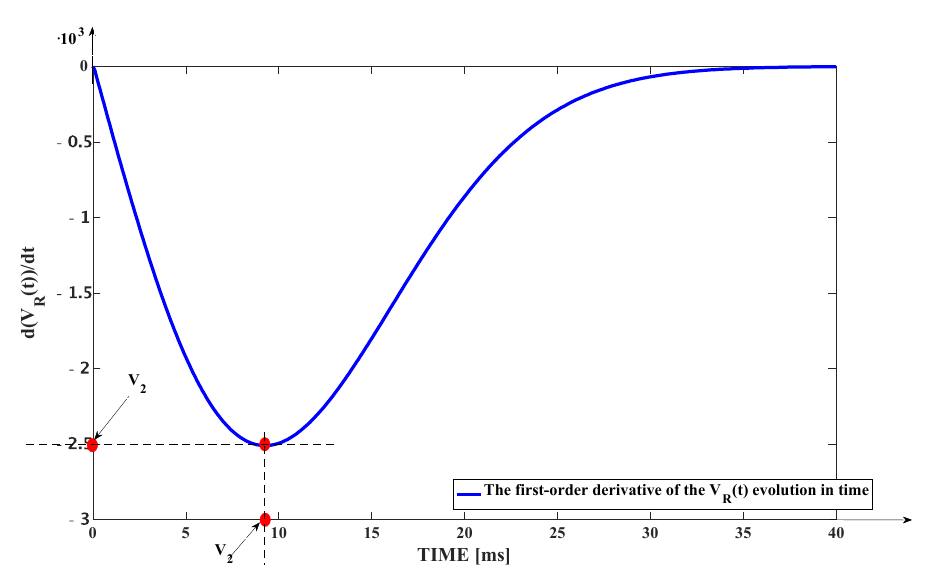
Figure 19. Dynamics of the first-order derivative of the V R (t) signal with respect to time in case of a transient fault.